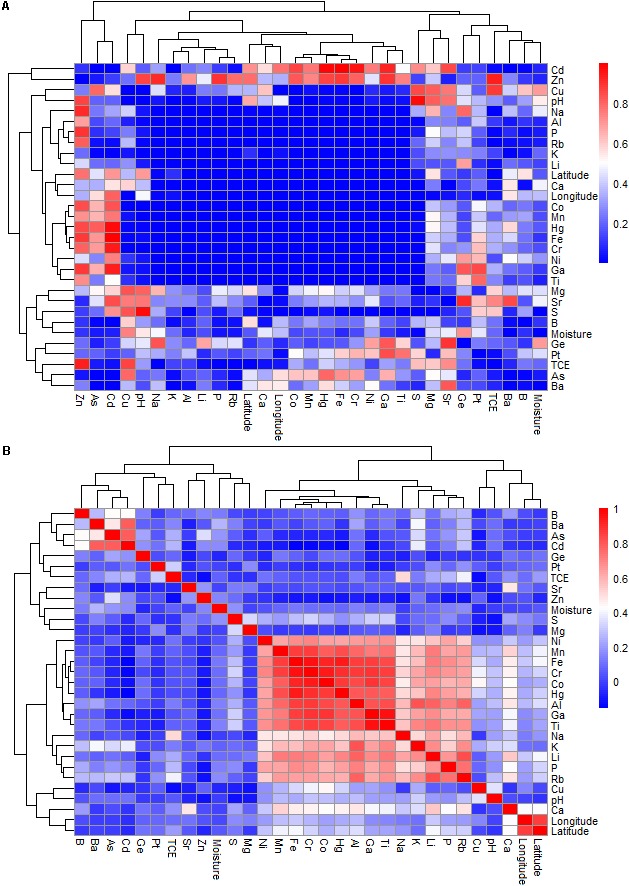
The Pearson’s correlation of geochemical variables of the study sites at the Gouchi salt lake, Yuncheng salt lake, and Luyang salt lake. (A,B) Represent P-value and correlation coefficient, respectively.